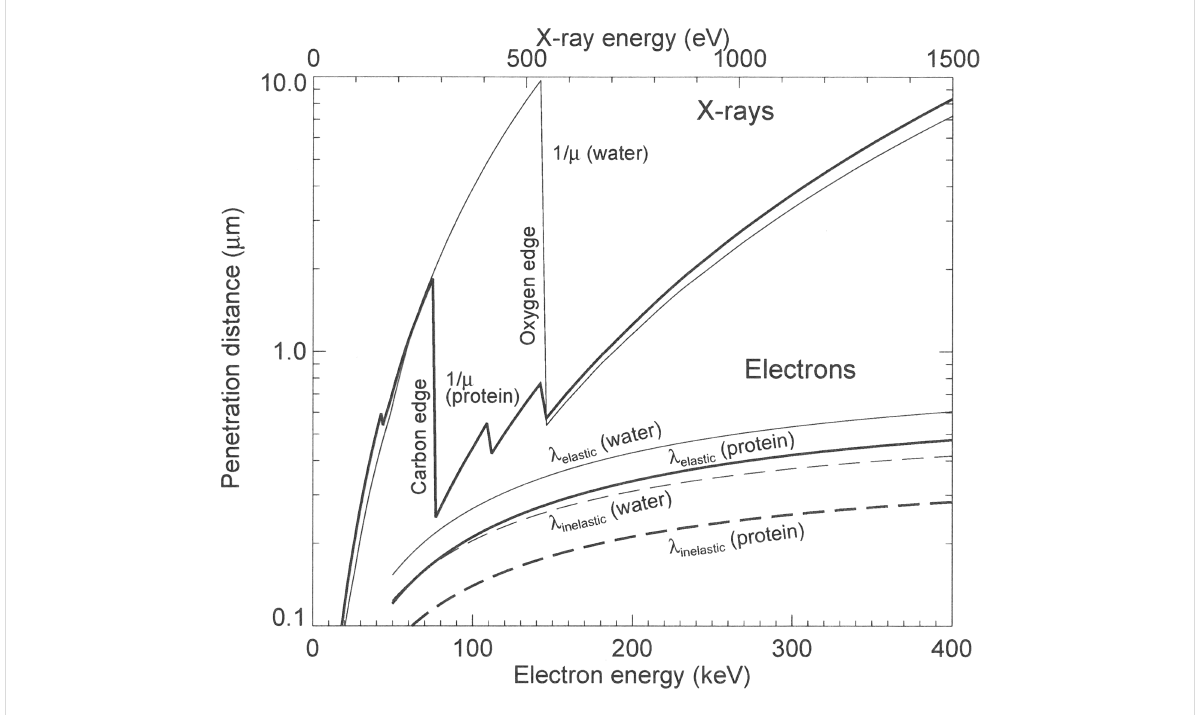
Figure 2: Calculated penetration depths of X-rays and electrons in dependence of their energy. The penetration depth of X-rays is larger than for electrons. In the so called “water window”, i.e., between the carbon and oxygen absorption edges at 284 and 543 eV protein and water have quite different absorption values which leads to a natural absorption contrast. Reprinted with permission from [30]. Copyright 1995 Cambridge University Press.